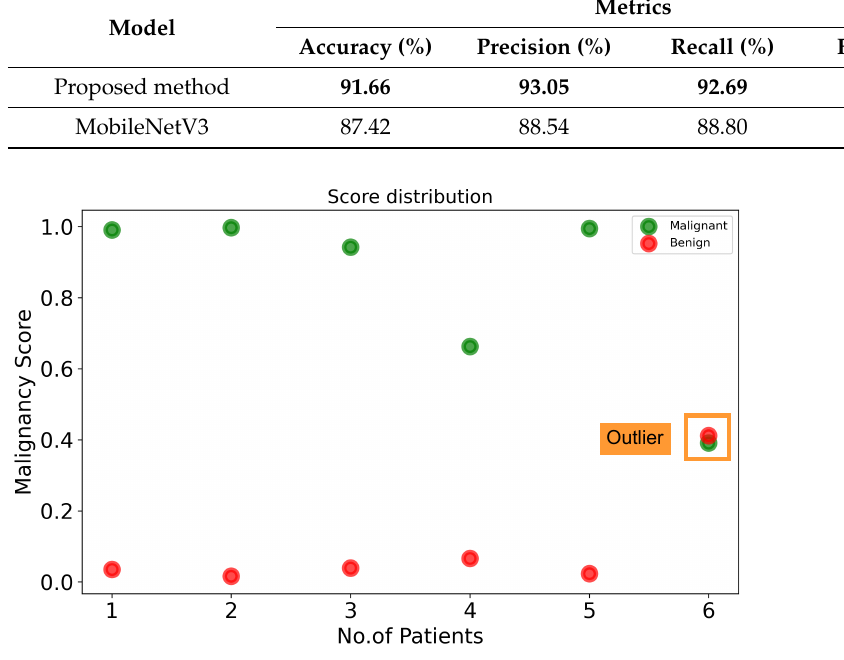
Figure 10. Illustration of patient-wise malignancy